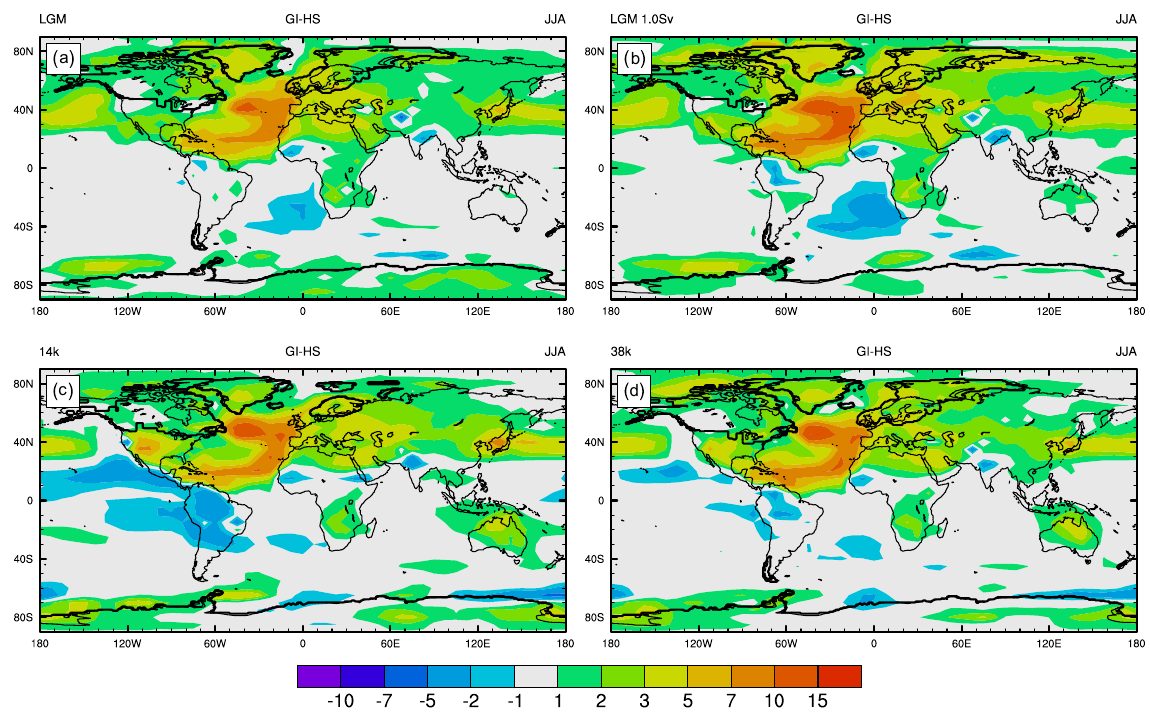
Fig. 2. Summer (JJA) GI–HS surface temperature anomalies ( ◦ C) in simulations with boundary conditions relevant to (a) the LGM, (b) the LGM with double the freshwater forcing compared with the other simulations, (c) 14kyr and (d) 38kyr. The distribution of land ice in each simulation is shown by the black contour